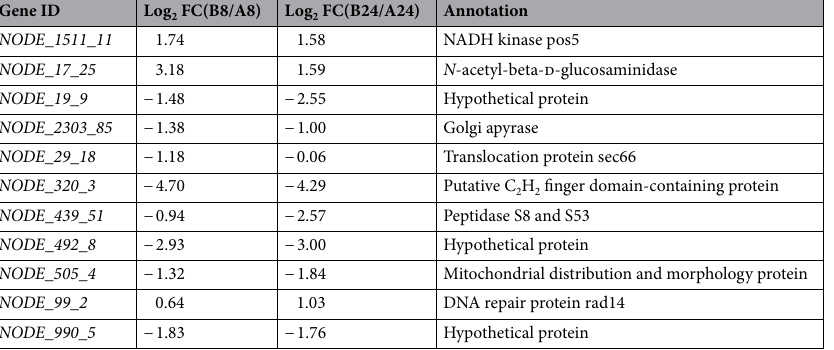
Table 2. Genes interacting with Crmapk that are differentially expressed in the transcriptome of the ΔCrmapk mutant parasitising S. sclerotiorum . Log 2 FC, the abbreviation of Log [base 2] fold change, represents the relative expression of each gene (log2 value) between the control and treatments. The letter “A” represents the controls (samples without sclerotia) and “B” represents the treatments induced by S. sclerotiorum sclerotia. The samples of two groups were collected at 8 and 24 h, respectively, and the data of gene expressions were derived from our previous research 10